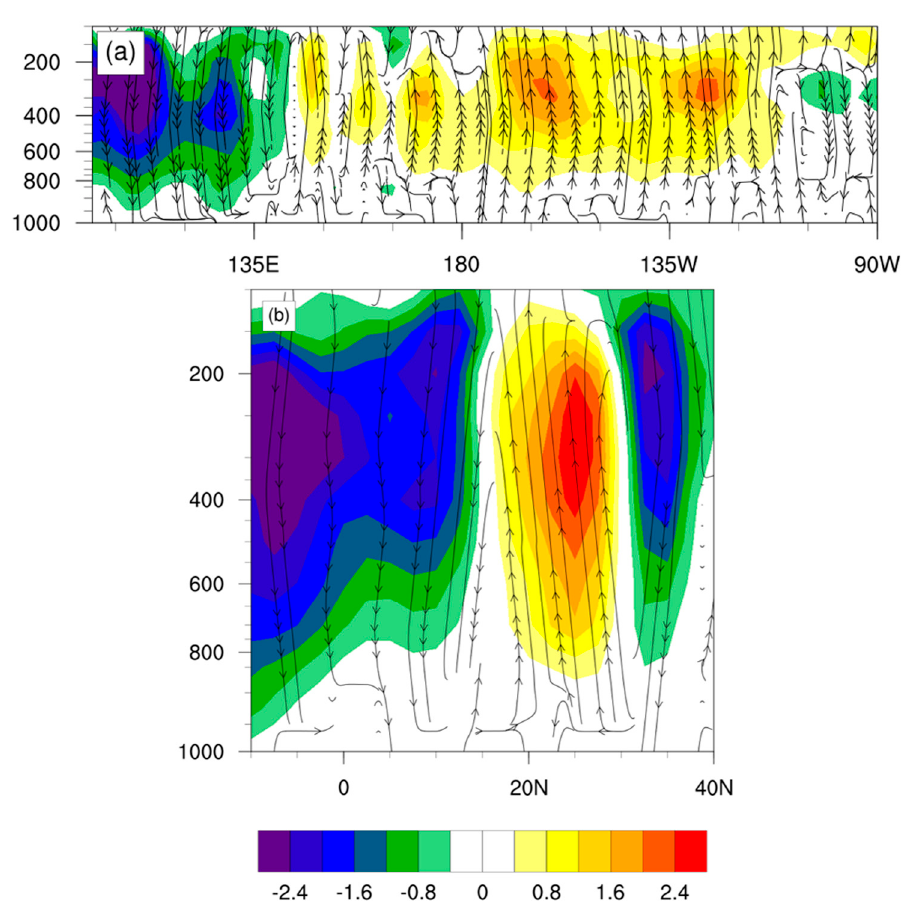
Figure 10. Composite differences of ( a ) Walker cell (averaged over 10°S~10°N) and ( b ) Hadley cell (averaged over 100~120°E) between wet and dry years in S1 (shading regions suggest composite differences of vertical velocity (unit: 10 - 3 m s - 1 ) between wet and dry years. Significant values exceeding the 95% confidence level are displayed).